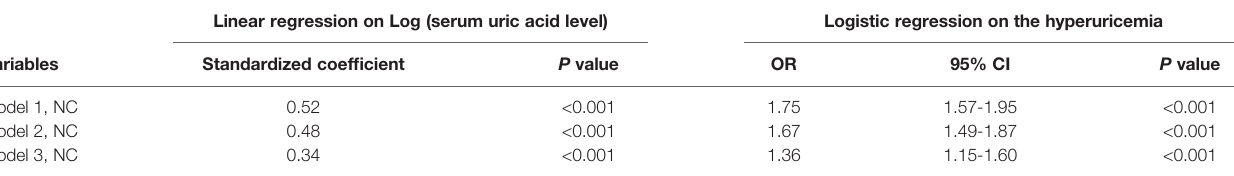
TABLE 2 | Association of neck circumference with serum uric acid level and hyperuricemia in women with polycystic ovary syndrome. Linear regression on Log (serum uric acid level) Logistic regression on the